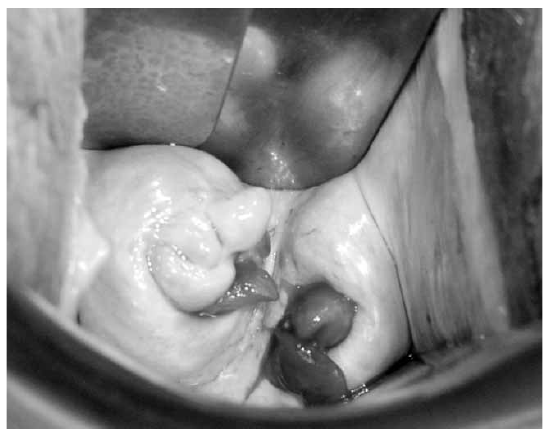
Figure 2. Granulation tissue located at the apices of the vaginal